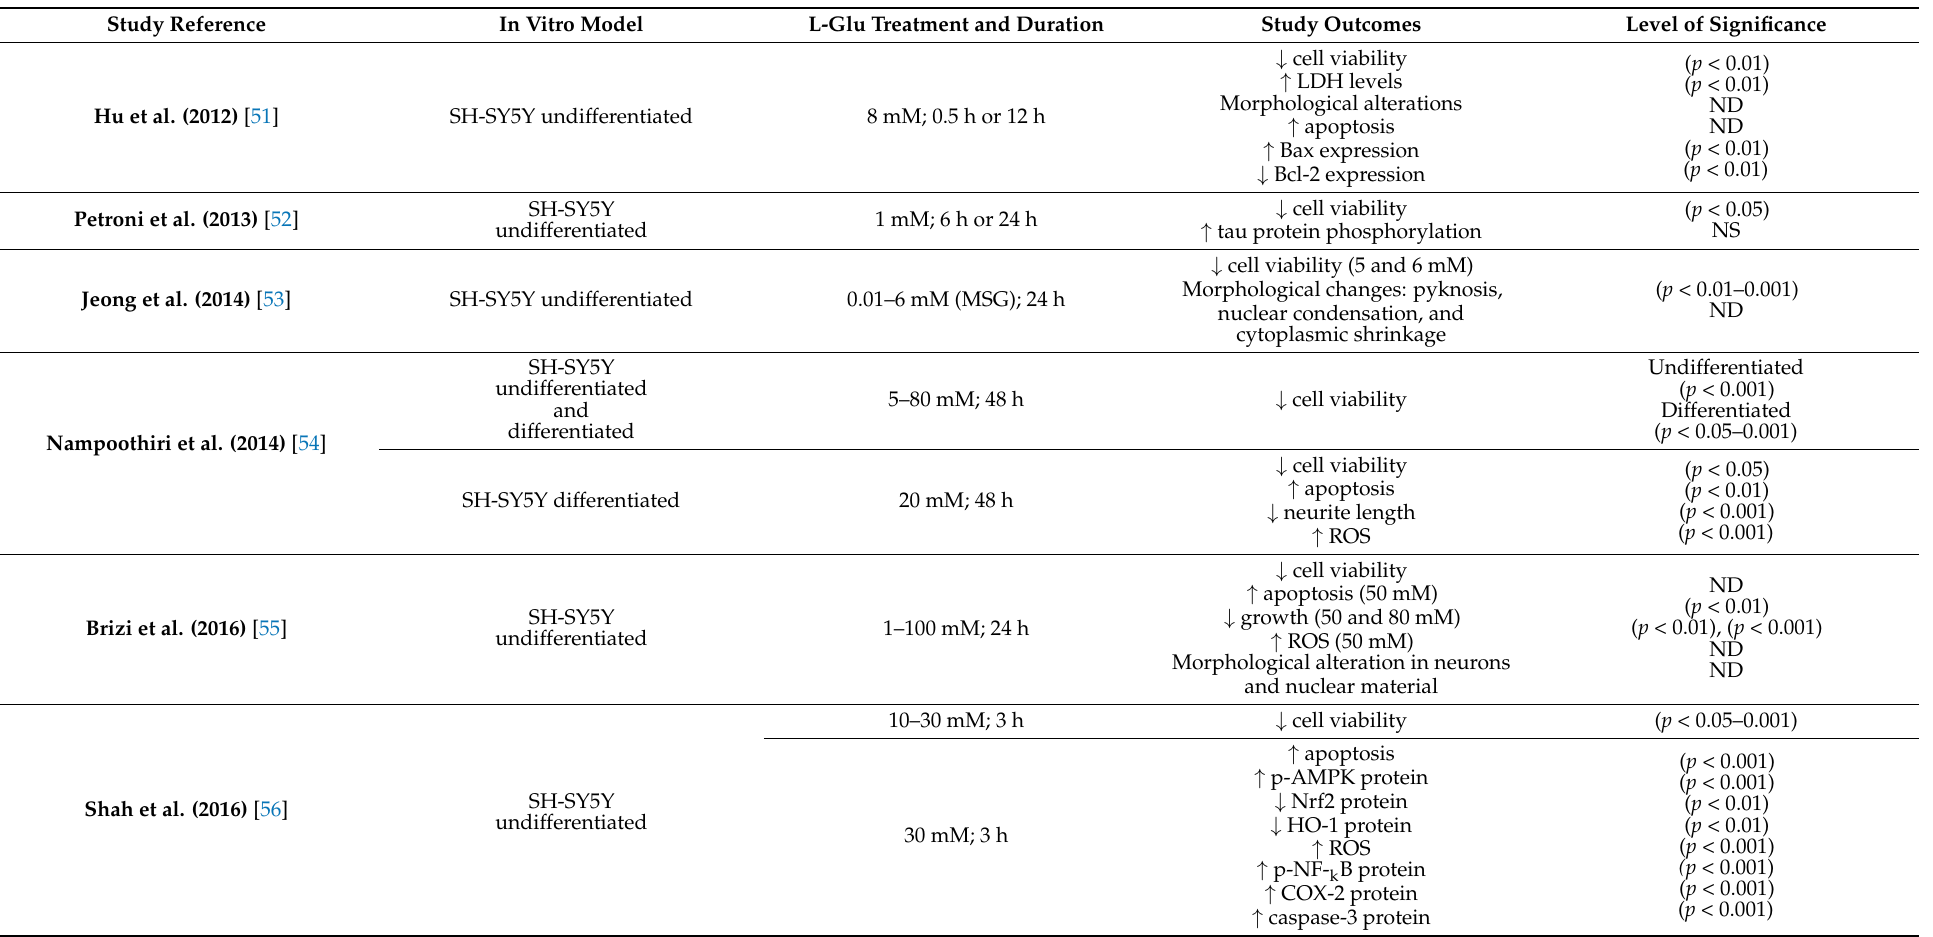
Table 1. L-glutamate in vitro studies’ outcome